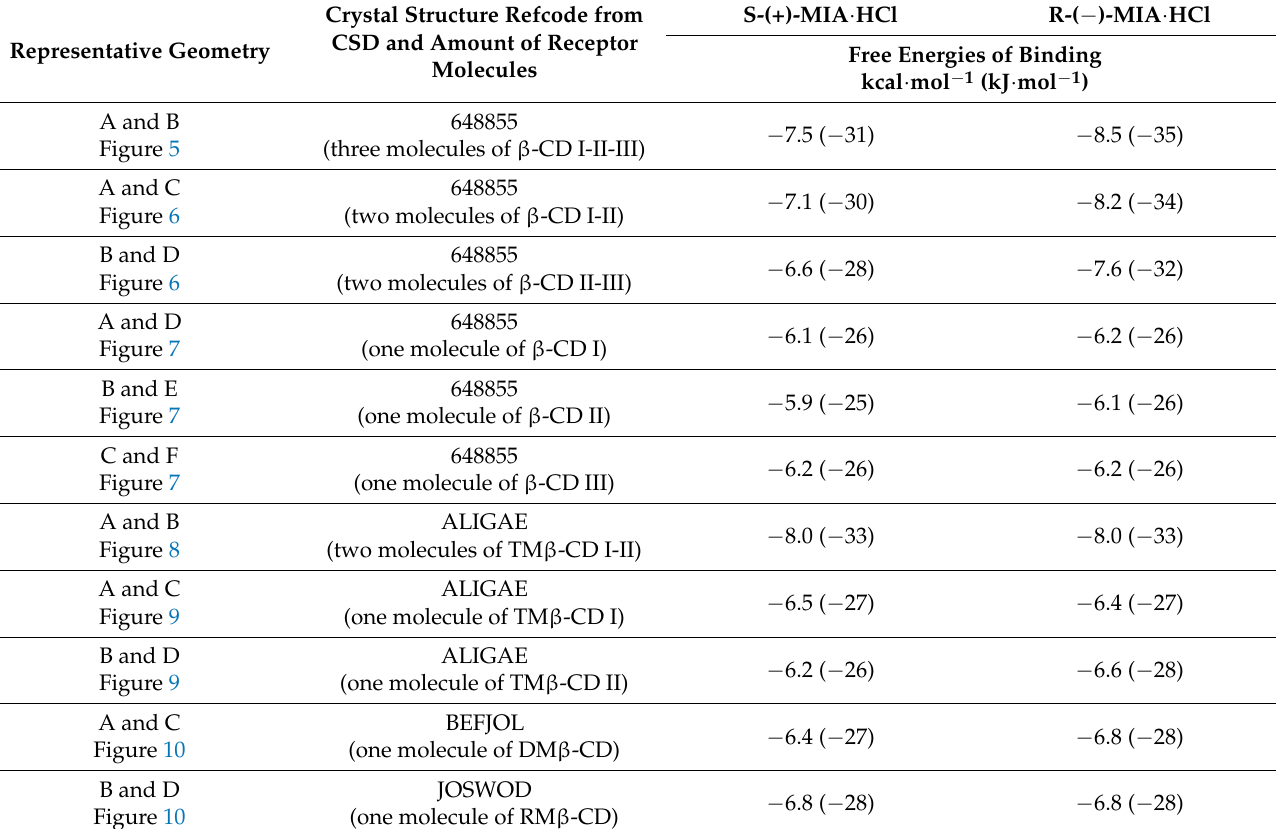
Table 2. The values of free energies of binding for MIA enantiomers and chosen β -CD molecules obtained from molecular docking